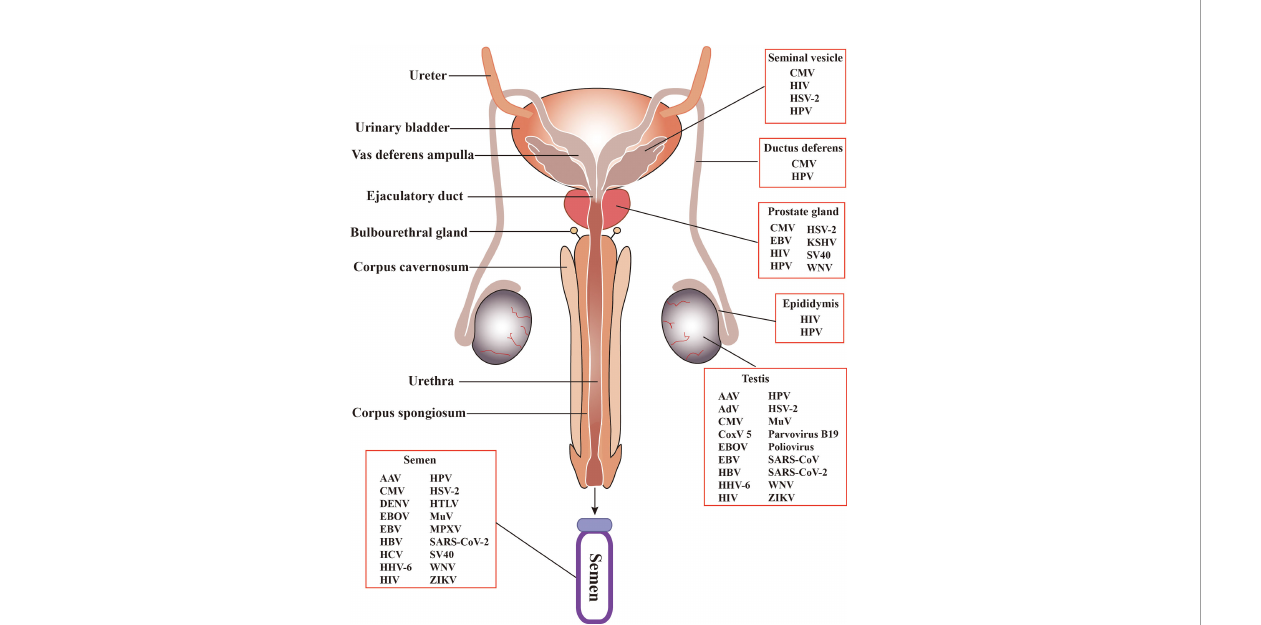
FIGURE 2 Schematic of the male reproductive system (MRS) and virus distribution. The MRS is composed of various organs, including testes, epididymides, the prostates, seminal vesicles, and bulbourethral gland. These organs are connected by genital ducts, including ductus deferens, vas deferens ampulla, ejaculatory duct and urethra. A broad spectrum of viruses have been detected in the MRS and in semen. AAV, Adeno-associated virus; AdV, Adenovirus; CMV, Cytomegalovirus; CoxV 5, Coxsackie virus 5; DENV, Dengue virus; EBV, Epstein-Barr virus; EBOV, Ebola virus; HBV, Hepatitis B virus; HCV, Hepatitis C virus; HHV-6, Human herpes virus -6; HIV, human immunode fi ciency virus; HPV, human papilloma virus; HSV, Herpes simplex virus; HTLV, Human T lymphotropic virus; KSHV, Kaposi sarcoma associated herpes virus; MuV, mumps virus; MPXV, Monkeypox virus. SARS-CoV, severe acute respiratory syndrome associated-coronavirus; SV40, Simian virus 40; WNV, West-Nile virus; ZIKV, Zika